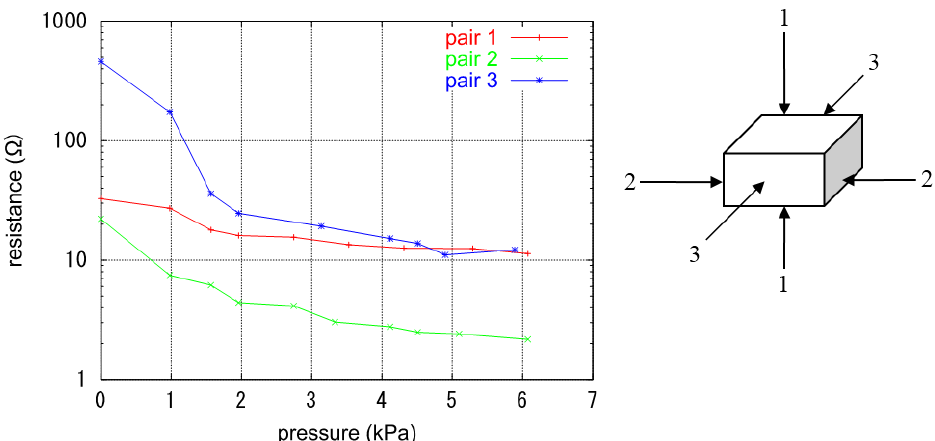
Figure 5. Relationships between compression pressure and electrical resistance. The schematic on the right labels pairs of opposing faces in the